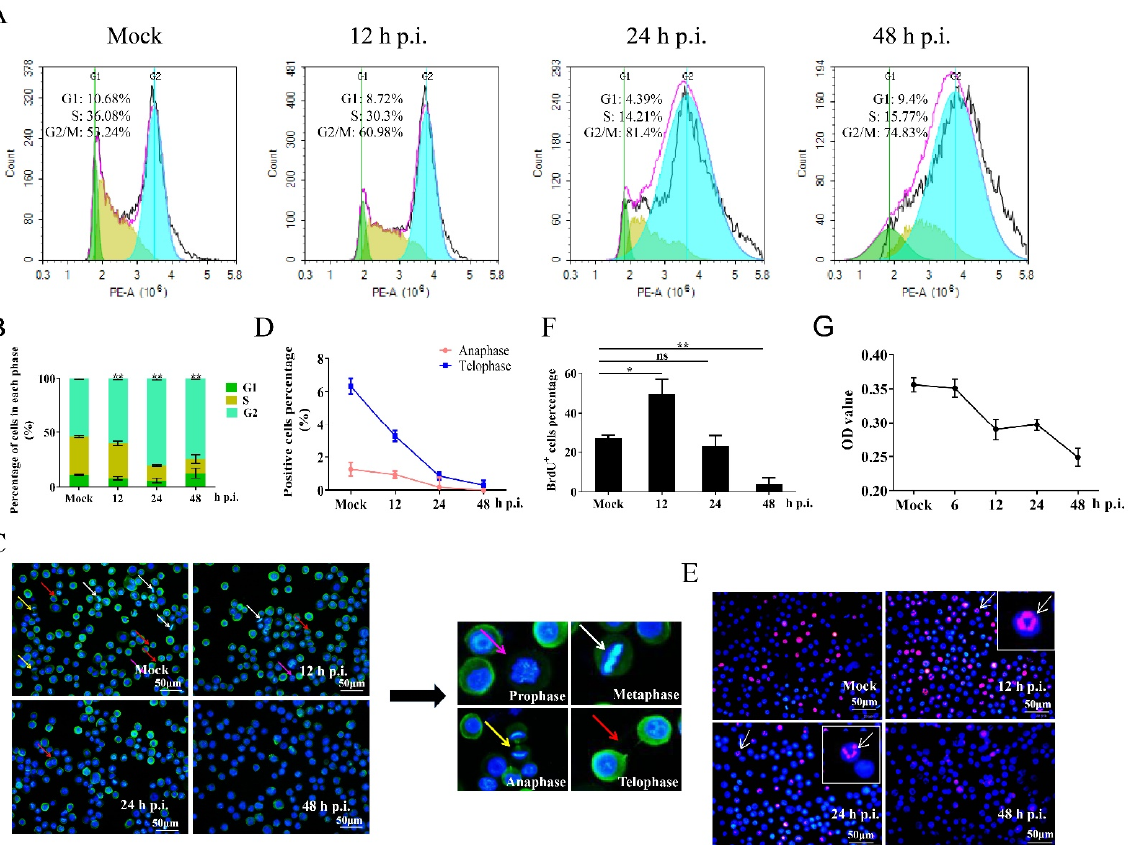
Figure 1. Regulation of the cell cycle in BmNPV-infected cells. BmN-SWU1 cells were infected with 1 MOI of BmNPV, and the cell cycle was analyzed at mock infection and different time points post infection. ( A , B ) Cellular DNA was stained by propidium iodide (PI), and the cell cycle distribution was determined in mock and infected cells by flow cytometry. The data were analyzed as mean ± SD from three independent experiments. ( C ) Mitotic stage was analyzed by Hoechst33342 (blue fluorescence) and tubulin (green fluorescence) staining. Pink arrow indicates prophase, white arrow indicates metaphase, yellow arrow indicates anaphase, and red arrow indicates telophase. Scale bar: 50 µ m. ( D ) Statistical analysis of the proportion of anaphase and telophase cells. ( E , F ) Comparison and statistical analysis of BrdU-positive cells. Anti-5-bromodeoxyurdine (anti-BrdU)-labeled BmN-SWU1 cells infected with or without BmNPV. White arrow indicates cells containing replicating viral genomes. Scale bar: 50 µ m. ( G ) Cell proliferation profile of BmN-SWU1 cells analyzed by MTS. OD: optical density. Statistical differences were analyzed with Student’s t -test (* p < 0.05 and ** p <